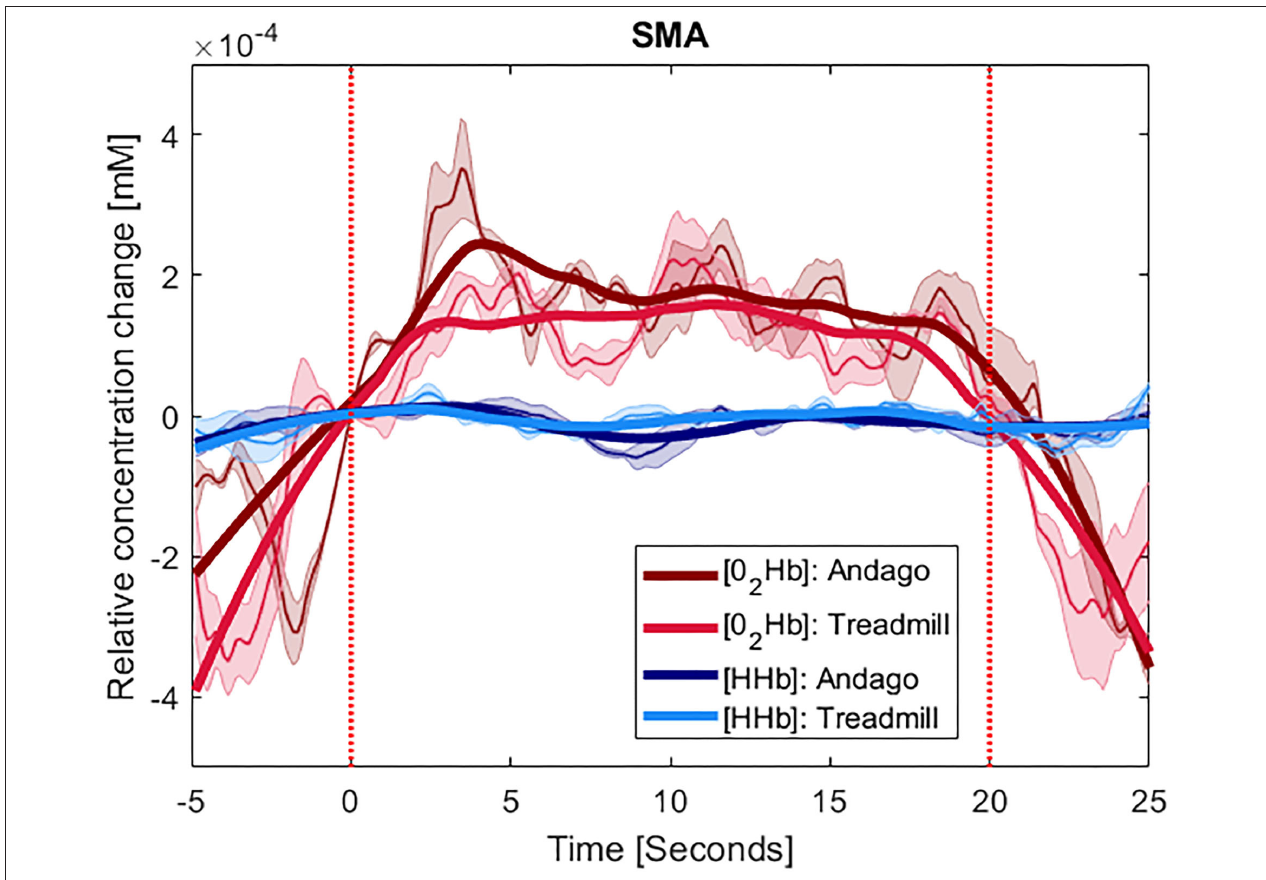
FIGURE 2 | Averaged time-series for group 1 for SMA. The y-axis shows the concentration changes in millimoles per liter (mM) of O 2 Hb in red and HHb in blue, averaged across the participants with at least one valid channel for the area. Thinner lines represent the averaged curves. The shaded area represents the standard error of the mean. The thick lines represent smoothened concentration changes. The x-axis represents the time of the stimulus (20s) plus the 5s before and 5s after it. The vertical red lines indicate the onset and end of the stimulus. The plots displaying the hemodynamic responses for the SMA were averaged over 4 participants (ID 3, 7, 13, and